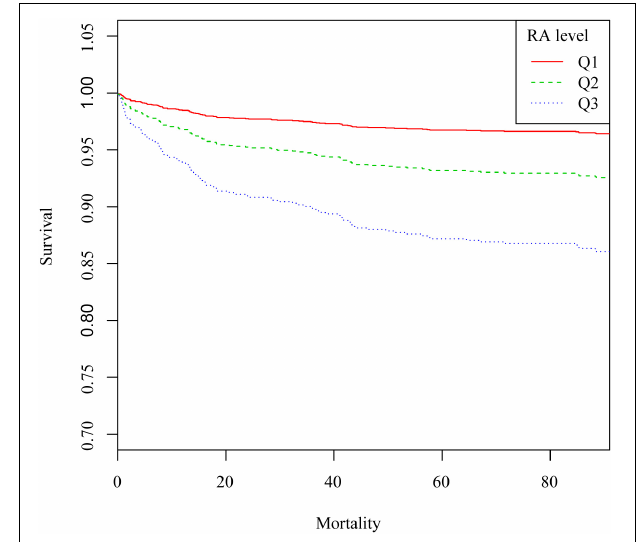
FIGURE 2 | Curve fitting of RA and 90-day all-cause mortality in patients with coronary heart disease, who had undergone PCI.